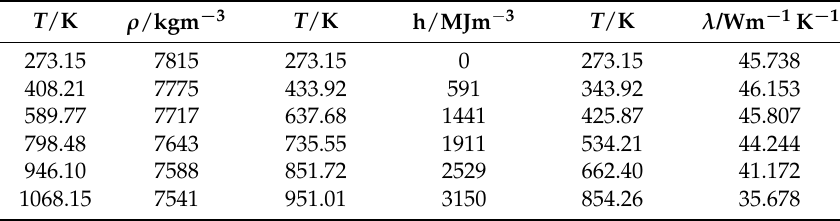
Table 4. Physical properties of